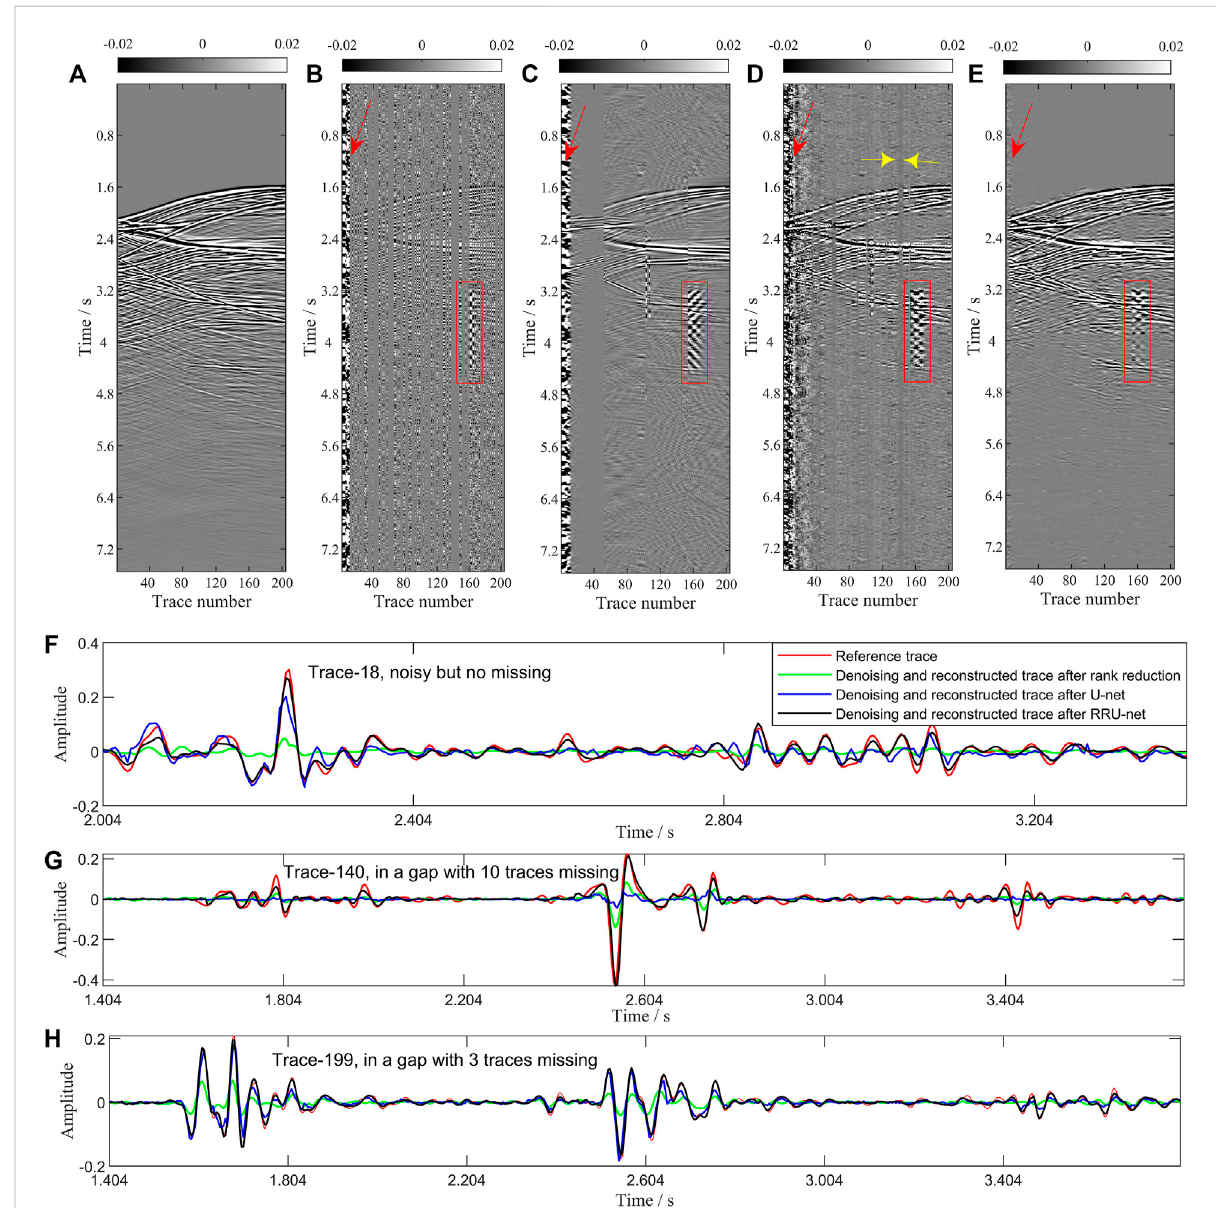
FIGURE 6 SimultaneousreconstructionanddenoisingresultsofthethreemethodsonsyntheticdatageneratedwiththeSEAMmodel. (A) Syntheticnoise- free complete signal data and the shot is located at x (cid:2) 6400 m. (B) Original gather with noise and the missing trace percentage is 63%. (C) Result by rank reduction. (D) Result by U-net. (E) Result by RRU-net. (F – H) One-dimensional waveform